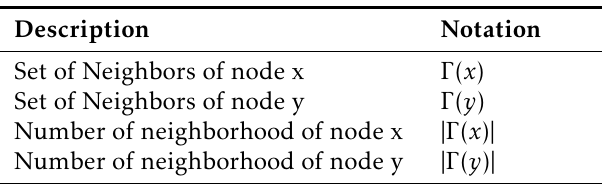
Table 1. Common Notations used in the Link Prediction approaches Description